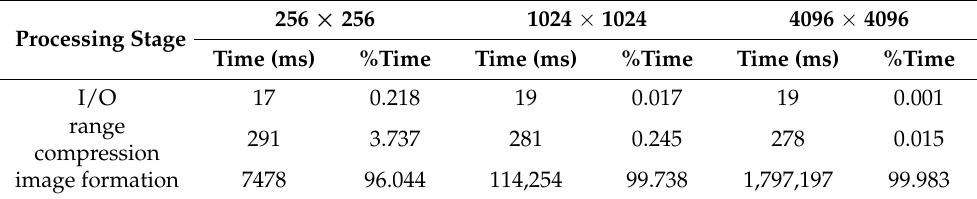
Table 2. The computational complexity of BP-VISAR baseline architecture F1.